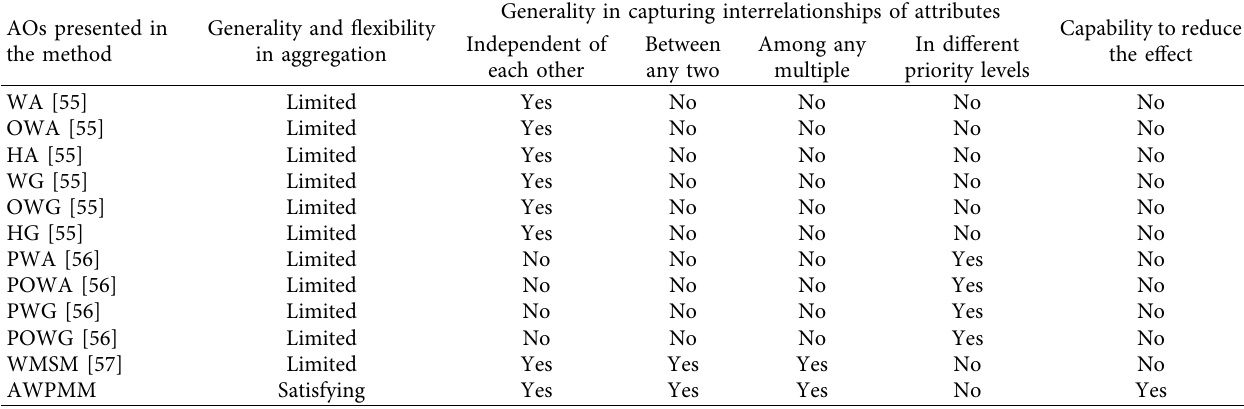
Table 4: The results of the qualitative comparison.